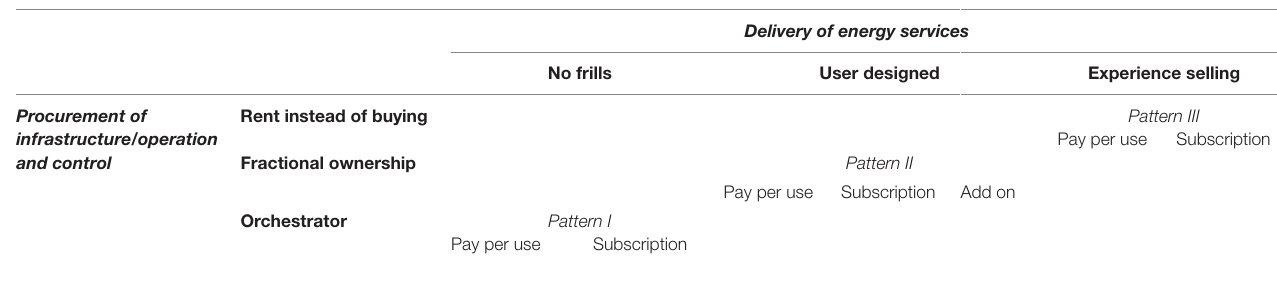
TaBle 3 | The business model patterns solution space and the reference